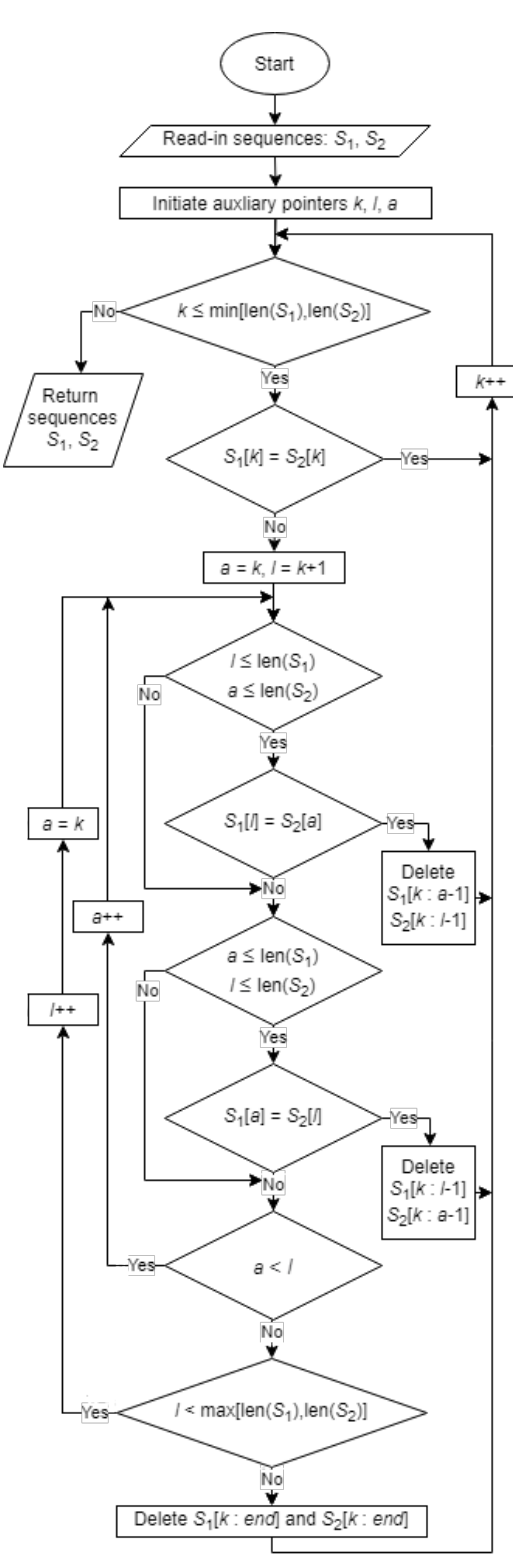
Figure 2. Block diagram of the algorithm for extracting common elements of two random sequences. Match optimization is performed by additionally checking if any element of S 1 matches any element of S 2 in the current range of optimization defined by the distancing indexes, k and l . For an increasing auxiliary index a starting at position k and pointing to the currently compared item, i.e., S 1 [ a ] or S 2 [ a ] , a match with the current reference